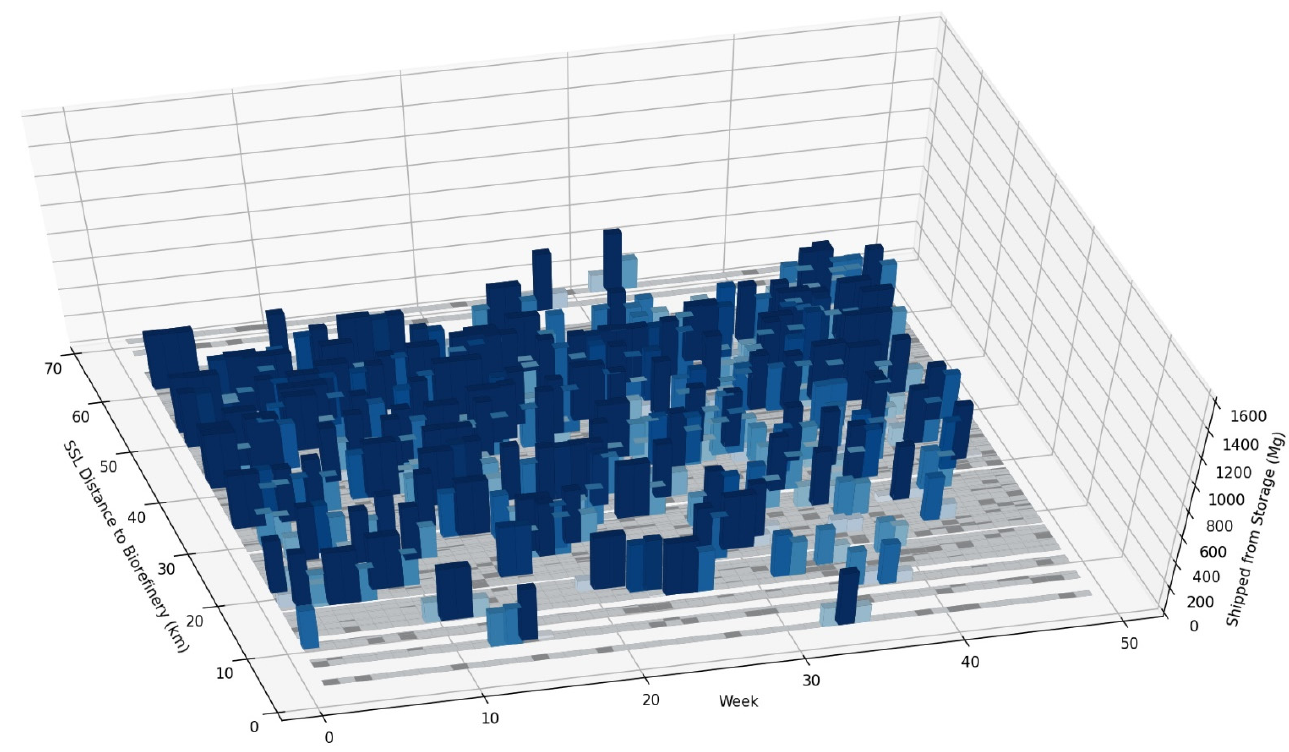
Figure 6. The amount of feedstock shipped from storage (Mg) for each SSL (sorted by travel distance to the biorefinery) over each week in the 49 ‐ week season for the eight ‐ load ‐ out simulation.